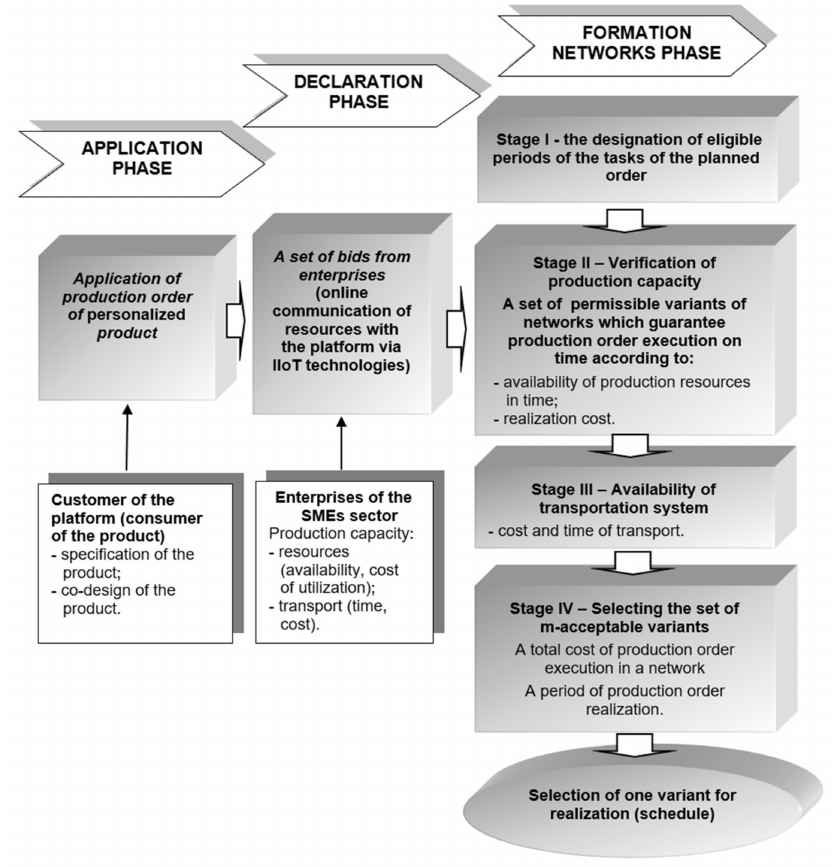
Figure 8. Outline of a platform planning methodology for cyber-physical networking. Source: own